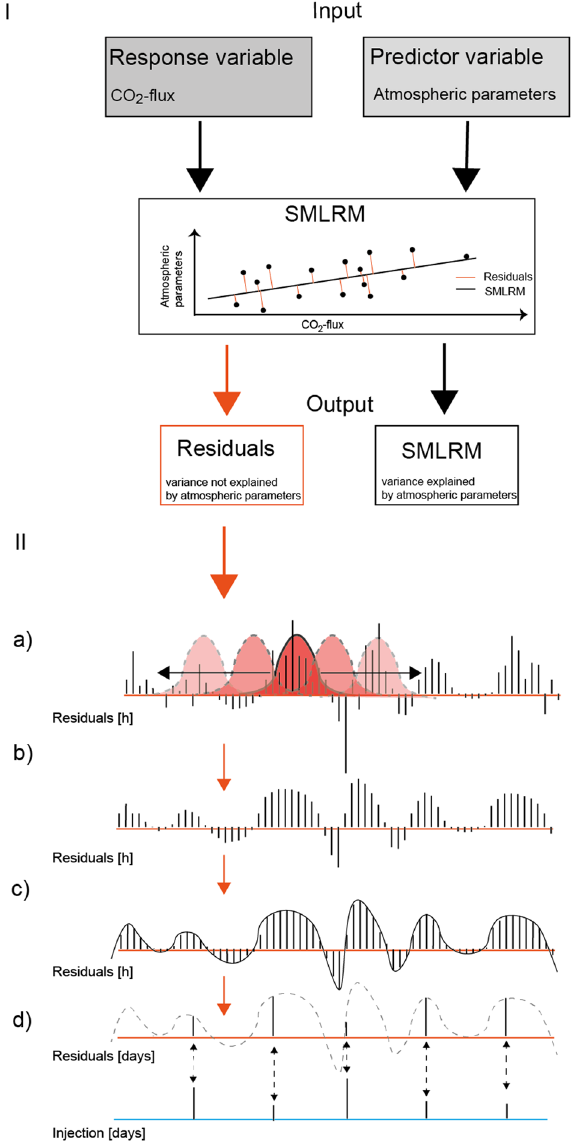
Figure 2. Workflow of the statistical analysis of the monitored data. Part I shows a flow chart of the stepwise multiple linear regression model (SMLRM). The SMLRM requires two input variables, the predictor variable, and the response variable. While the predictor variable usually consists of a multidimensional data set, as in our case atmospheric parameters (e.g., air temperature, wind speed), the response variable is a one-dimensional data set (measured CO 2 flux). The output of the SMLRM is a linear regression model that represents the variability of the response variable according to the predictor variables. The remaining residuals represent the variability of the response variable which is not explained by the predictor variables. In this study we focused on the residuals. Part II visualizes the resampling of the residuals. ( a ) Describes the application of the 24-h Gaussian filter running in both, forward and reverse directions, ( b ) to smooth the hourly measured CO 2 fluxes. ( c ) Shows the application of a shape-preserving piecewise cubic interpolation and finally, ( d ) resampling of